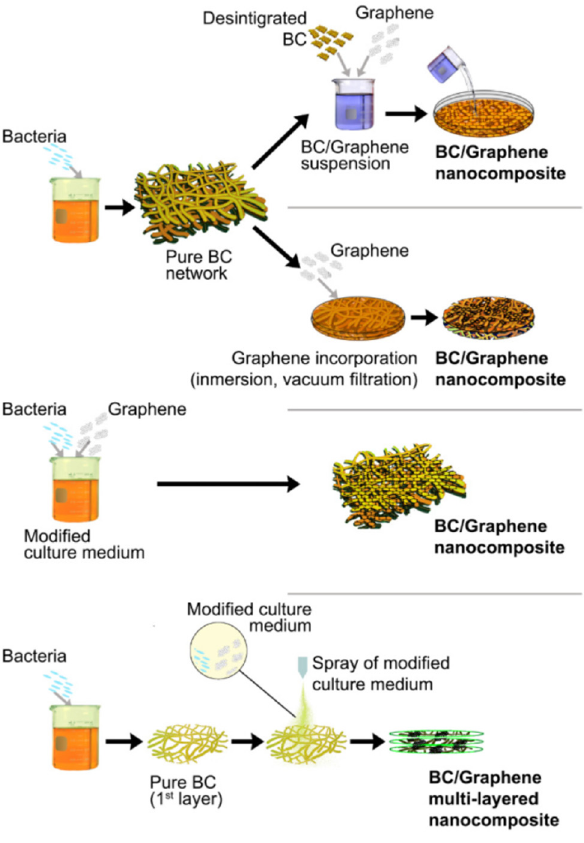
Figure 3: Some utilized processing routes for the preparation of bacterial cellulose – graphene oxide nanocomposites [ 11 ]